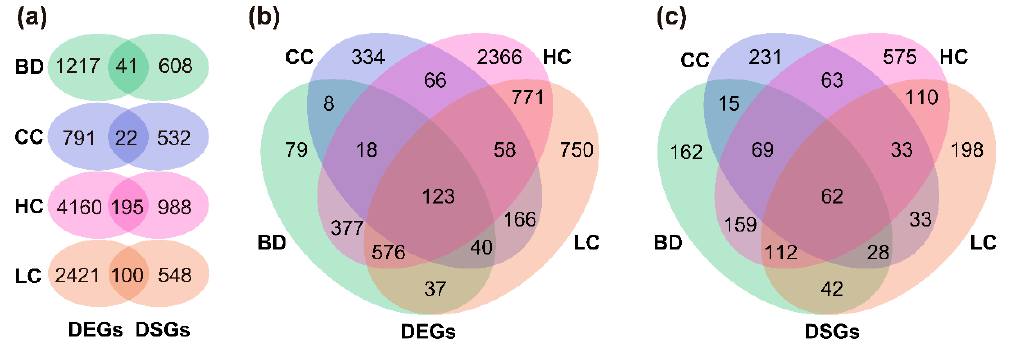
Figure 3. ( a ) Intersections between the DEGs and DSGs in groups of the same traits; intersections between ( b ) the DEGs and ( c ) DSGs in groups of different traits.